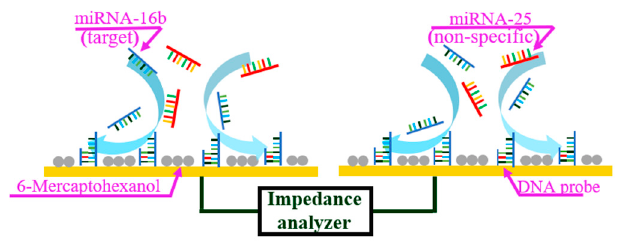
Figure 1. ACET microflow accelerates the binding of miRNA ‐ 16b and DNA probe.